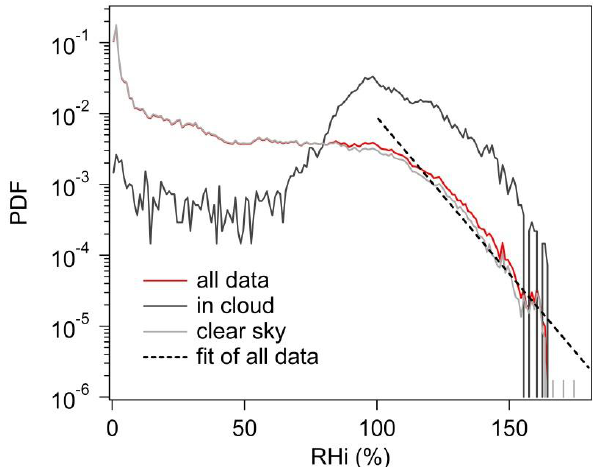
Fig. 4. Probability density functions (PDFs) of RHi for 1Hz START08 and HIPPO 2–5 data. Different colors represent RHi of all data (red), the clear-sky (light grey) and the in-cloud data (dark grey). For all the 1Hz data (red), the PDF of RHi >100% follows an exponential decay: ln(PDF)= a + b × RHi, where a =5.4 ± 0.5, b = − 0.10 ± 0.003 ( ± σ , σ is 1 standard